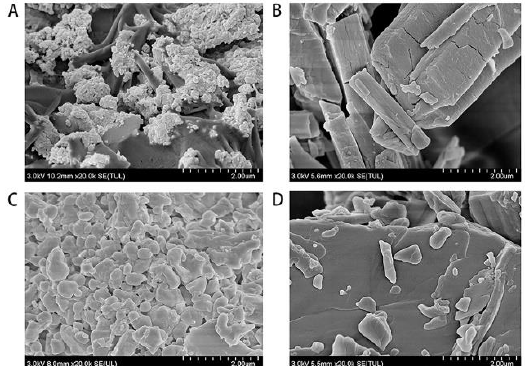
Figure 2. Scanning electron microscopy micrographs and particle size of BER/CS and PHI/CS. ( A ) BER/CS (measured at 2 µm scale and 20,000× magnification); ( B ) BER (measured at 2 µm scale and 20,000× magnification); ( C ) PHI/CS (measured at 2 µm scale and 20,000× magnification); ( D ) PHI (measured at 2 µm scale and 20,000× magnification).